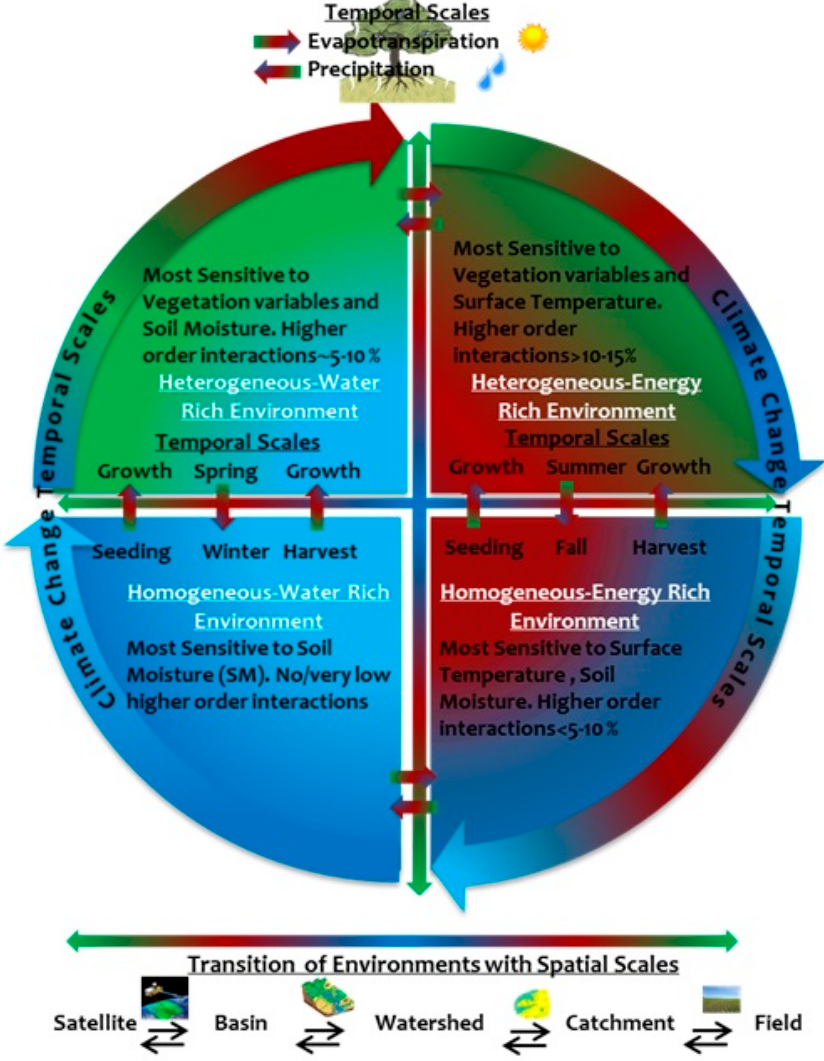
Figure 7. The conceptual model describes the classification of environments as homogenous and heterogeneous environments based on density and heterogeneity in biomass (green). Each of these environments can further be classified as water (blue) and energy (red) rich environments. Top-Left quadrant represents a heterogeneous water rich environment, where brightness temperature is most sensitive to vegetation and soil moisture with higher order interactions of ~5–10%; Top-Right quadrant represents a heterogeneous energy rich environment, where brightness temperature is most sensitive to vegetation and temperature with higher order interactions of > 10–15%; Bottom-Left quadrant represents a homogeneous water rich environment, where brightness temperature is most sensitive to soil moisture with no or very low higher order interactions; Bottom-Right quadrant represents a homogeneous energy rich environment, where brightness temperature is most sensitive to soil moisture and temperature with higher order interactions of < 5–10%. The transition from homogenous to heterogeneous, energy rich to water rich, and vice versa, can occur through spatio-temporal scales (spatial: extent and support; time: day, month, seasonality, climate change, etc.) following land-use / land-cover change and events such as precipitation, evapotranspiration, etc. The lasting transition from homogeneous to heterogeneous and vice versa can also occur at the climate change temporal